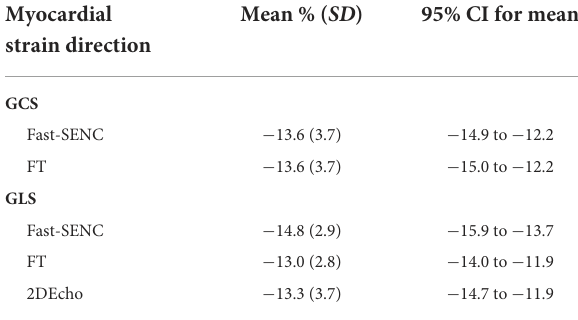
TABLE 2 Global circumferential and longitudinal